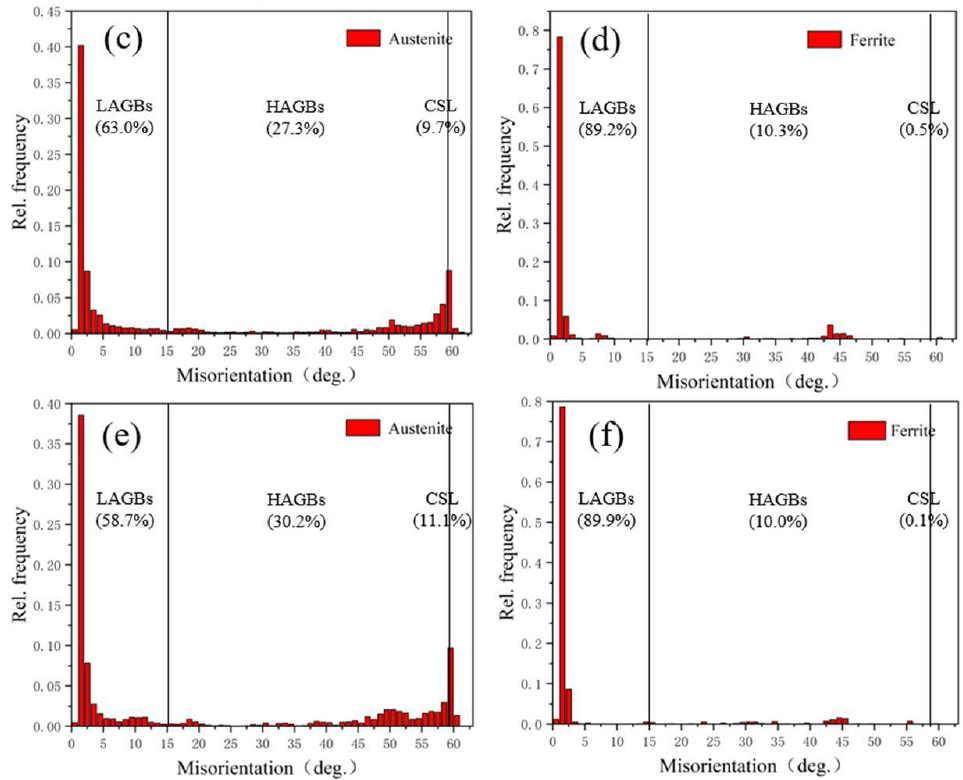
Figure 9. Misorientation angle distribution of ferrite and austenite grain boundaries of weld under different alternating magnetic field intensities. ( a , b ) 0 mT; ( c , d ) 20 mT; ( e , f ) 30 mT.